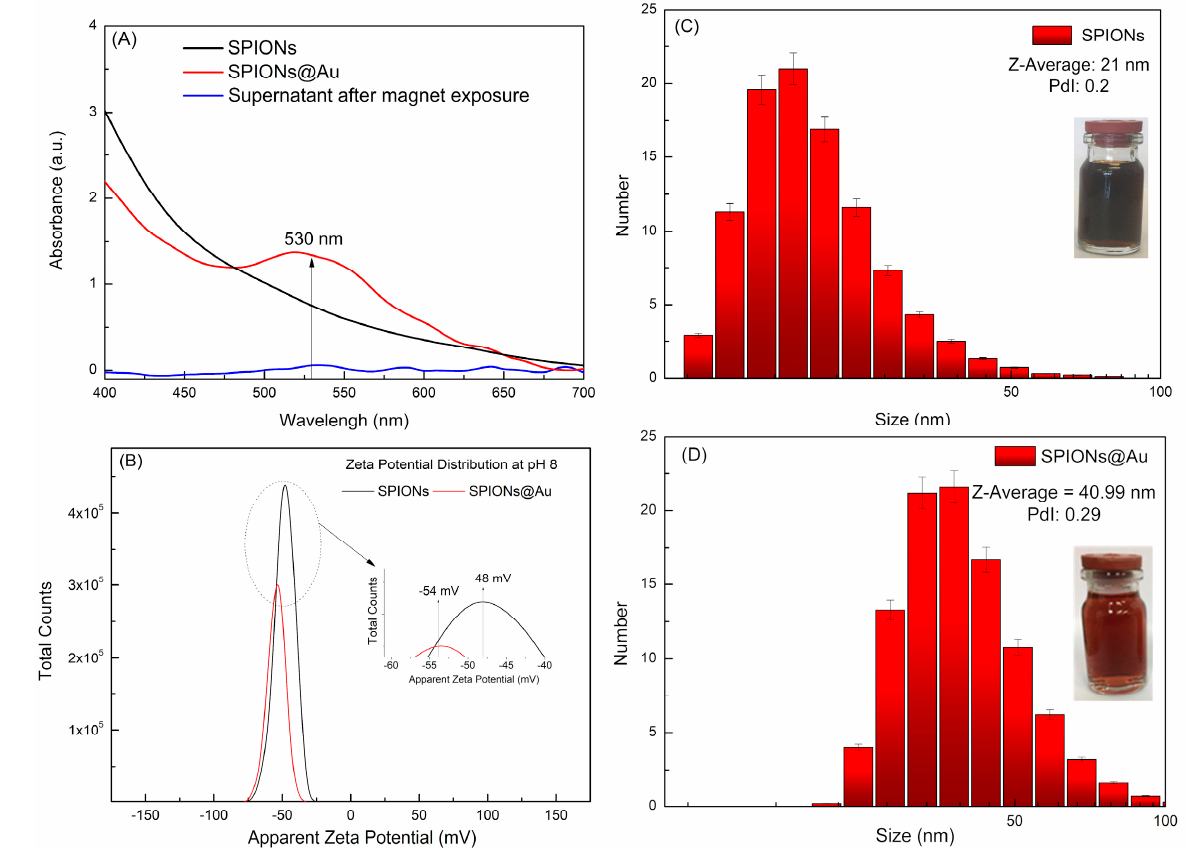
Figure 1. Characterization: ( A ) absorption spectra in the UV-Visible region, ( B ) Zeta Potencial Value for both nanoparticles, ( C ) hydrodynamic diameter distribution of SPIONs and ( D ) hydrodynamic diameter distribution of SPIONs@Au.